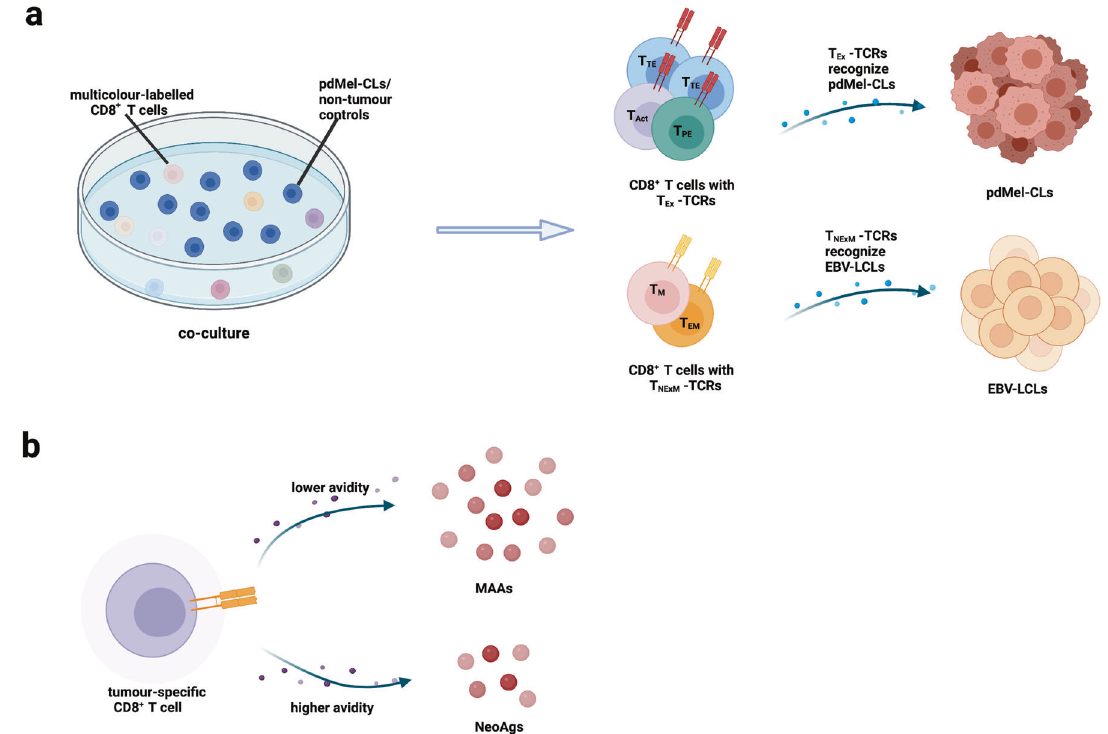
Fig. 1 Model of the relationship between cellular phenotype and TCR properties. a Measuring upon co-culture of multicolor-labeled CD8 + T cells against pdMel-CLs and against EBV-LCLs with peptides from NeoAgs, MAAs or viral antigens. CD8 + TILs with exhausted states (including T TE , T Act and T PE ) were enriched in antitumour speci fi cities, whereas CD8 + TILs with memory states (including T EM and T M ) predominantly recognize EBV-LCLs. b The concentration level of cognate antigens in fl uences the avidity of tumor speci fi c TCRs. The fi gure was generated on Biorender.com. Abbreviations: T TE terminally exhausted T cell, T Act acutely activated T cell, T PE precursor exhausted T cell, T EM effector memory T cell, T M memory T